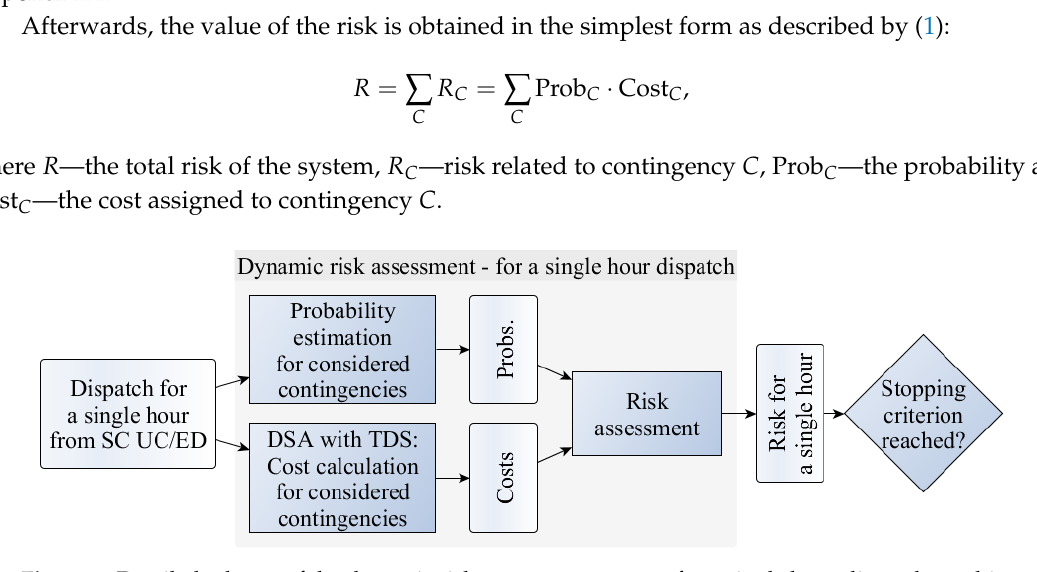
Figure 2. Detailed scheme of the dynamic risk assessment process for a single hour dispatch resulting from the SC UC/ED solution.